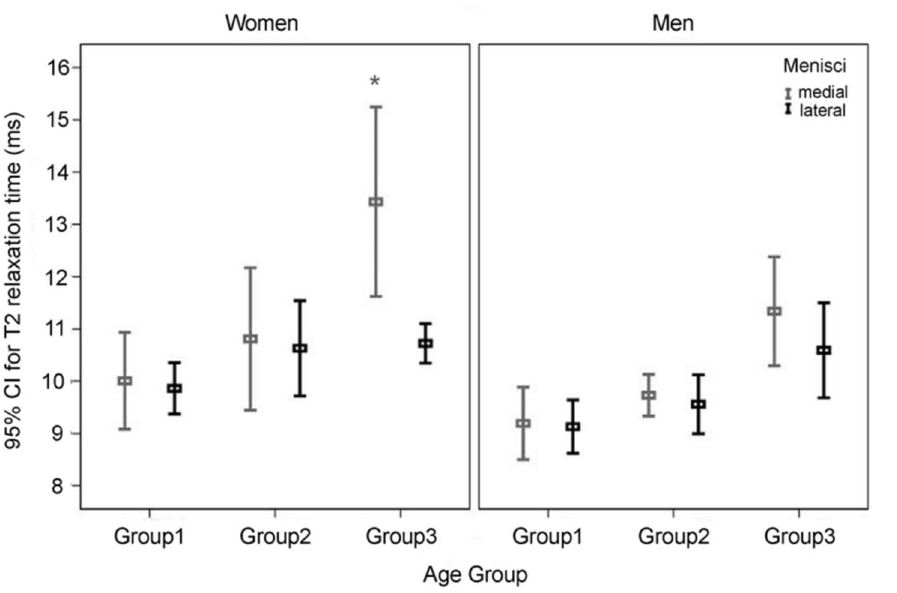
Figure 4. T2 values of the medial and lateral menisci in three age groups of women and men. The T2 values of the medial meniscus for women increase significantly from group 1 to group 3 (* P , 0.001 as compared with group 1). But the T2 values of the lateral meniscus for women and men were not significantly different among three age groups. doi:10.1371/journal.pone.0059769.g004 PLOS ONE |